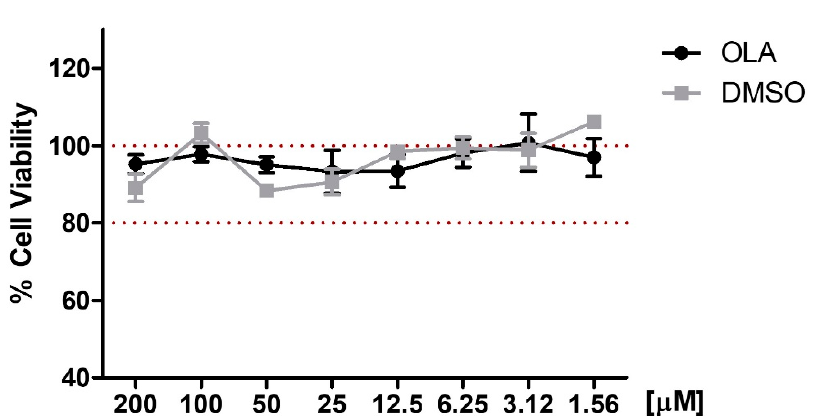
Figure 1. Effect of OLA on cell viability. Cells were treated with OLA (200–1.6 µ M) for 18 h. Cell survival was expressed as the percentage of viability with respect to control untreated cells (100%). Data are represented as means ± SEM ( n = 6).